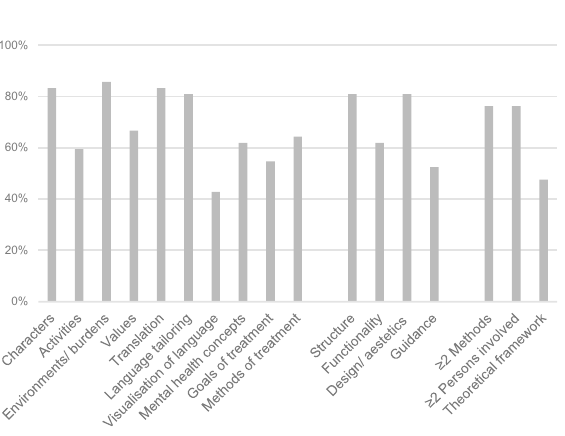
Fig. 2 Taxonomy of cultural adaption of internet- and mobile- based interventions (IMI). Percentages of the 42 included IMI that ful fi lled the respective content, methodological, and procedural components of the